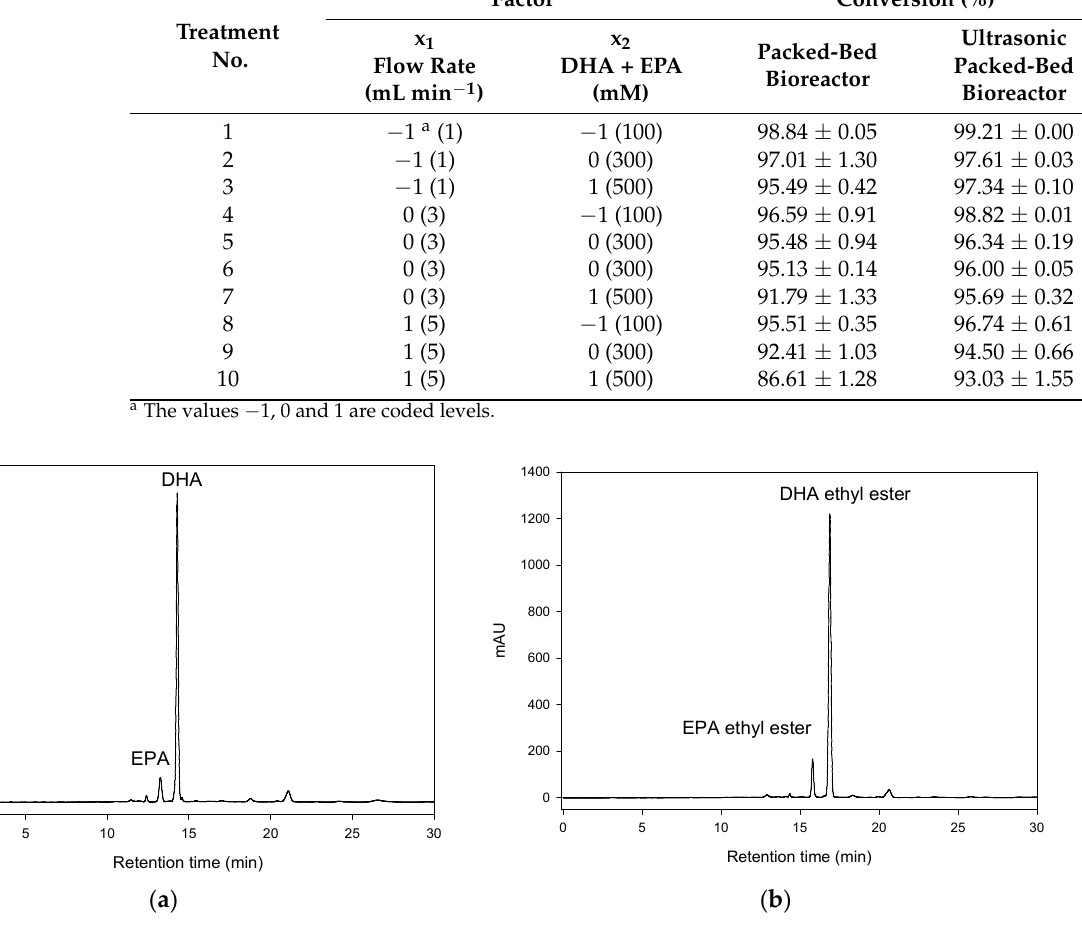
Figure 2. HPLC analysis of ( a ) the reaction mixture and ( b ) product eluting from the lipase packed- bed bioreactor.